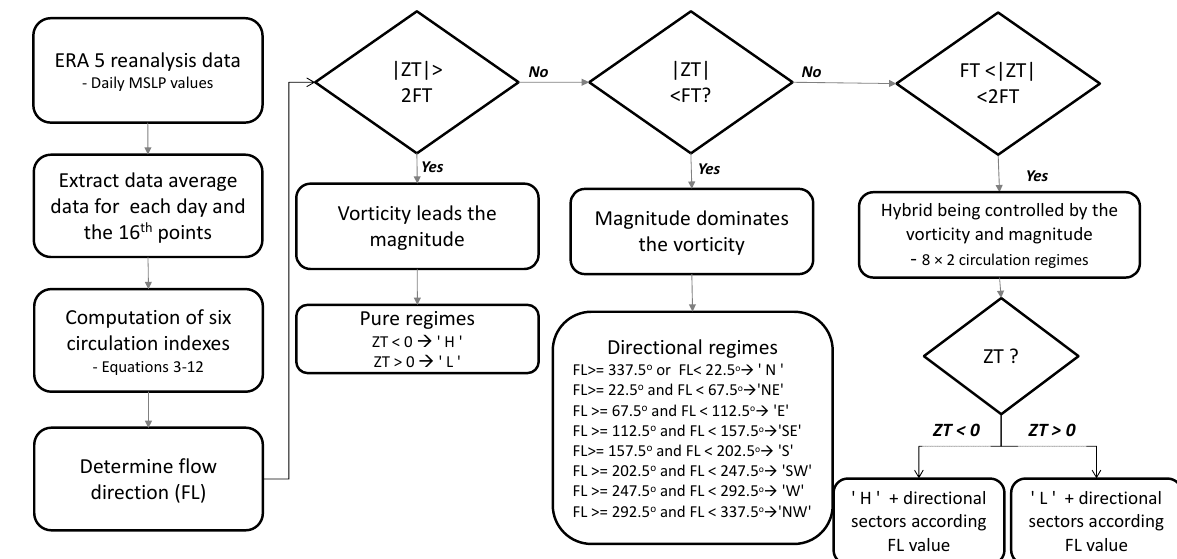
Figure 3. Flowchart of the main steps implemented for the weather regime classification. To identify the typical weather pattern for each weather circulation type, the MSLP fields for each of the 16 grid points depicted in Figure 2 were used. Considering all the days d for a specific weather circulation type, and the correspondent spatial grid points 𝑝 (cid:3031),(cid:3037) , with j = 1, …, 16, the representative day for each weather circulation type can be obtained with the following expressions [32]: